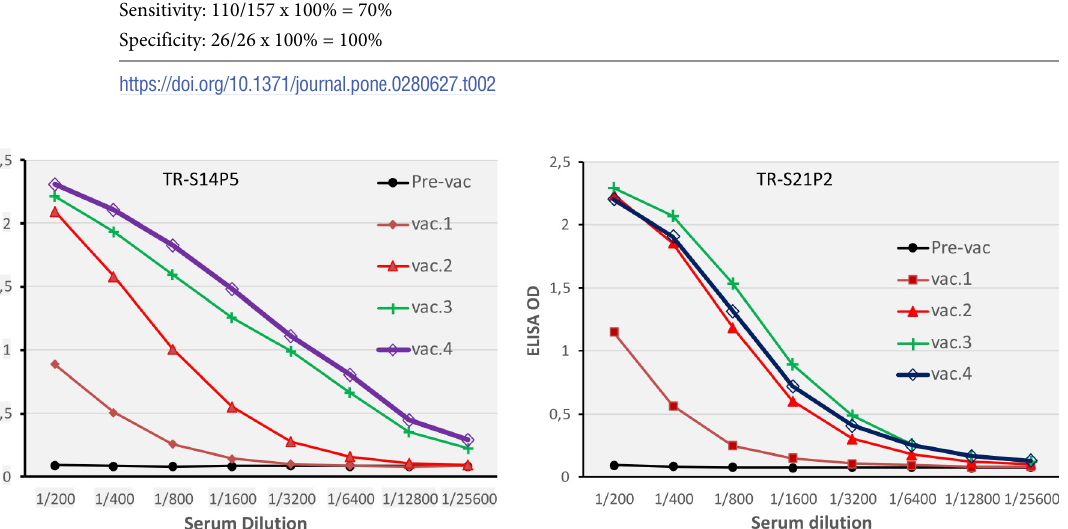
Fig 4. Antibody (IgG) responses in rabbits immunized with TR-S14P5 (left) or TR-S21P2 (right). Two rabbits were immunized with each recombinant. Immunizations were carried out four times with three-week intervals between vaccination, with a dose of 250 μ g, and with complete Freund’s, incomplete Freund’s, Quil A, and Quil A adjuvant for the first, second, third and fourth immunizations.